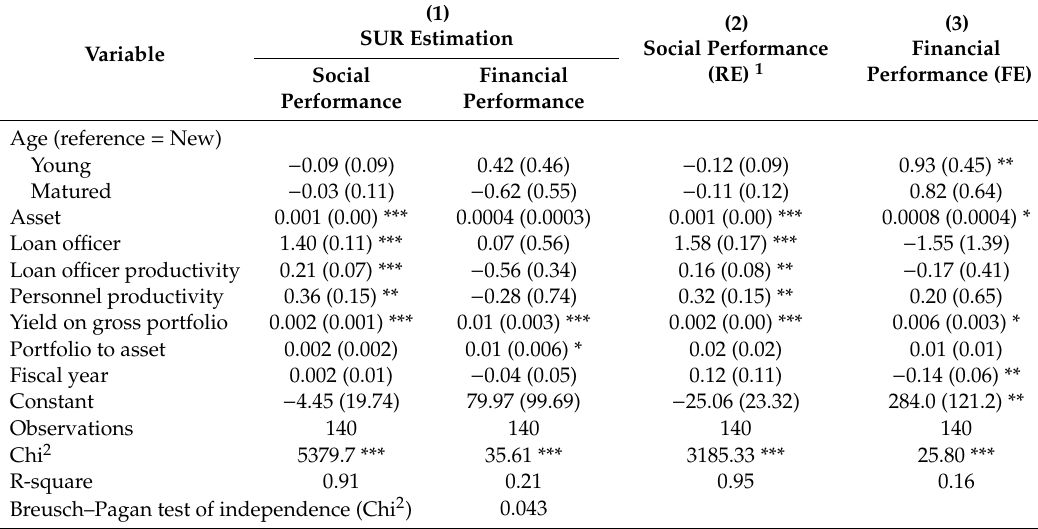
Table 3. Factors driving the performance of MFIs in